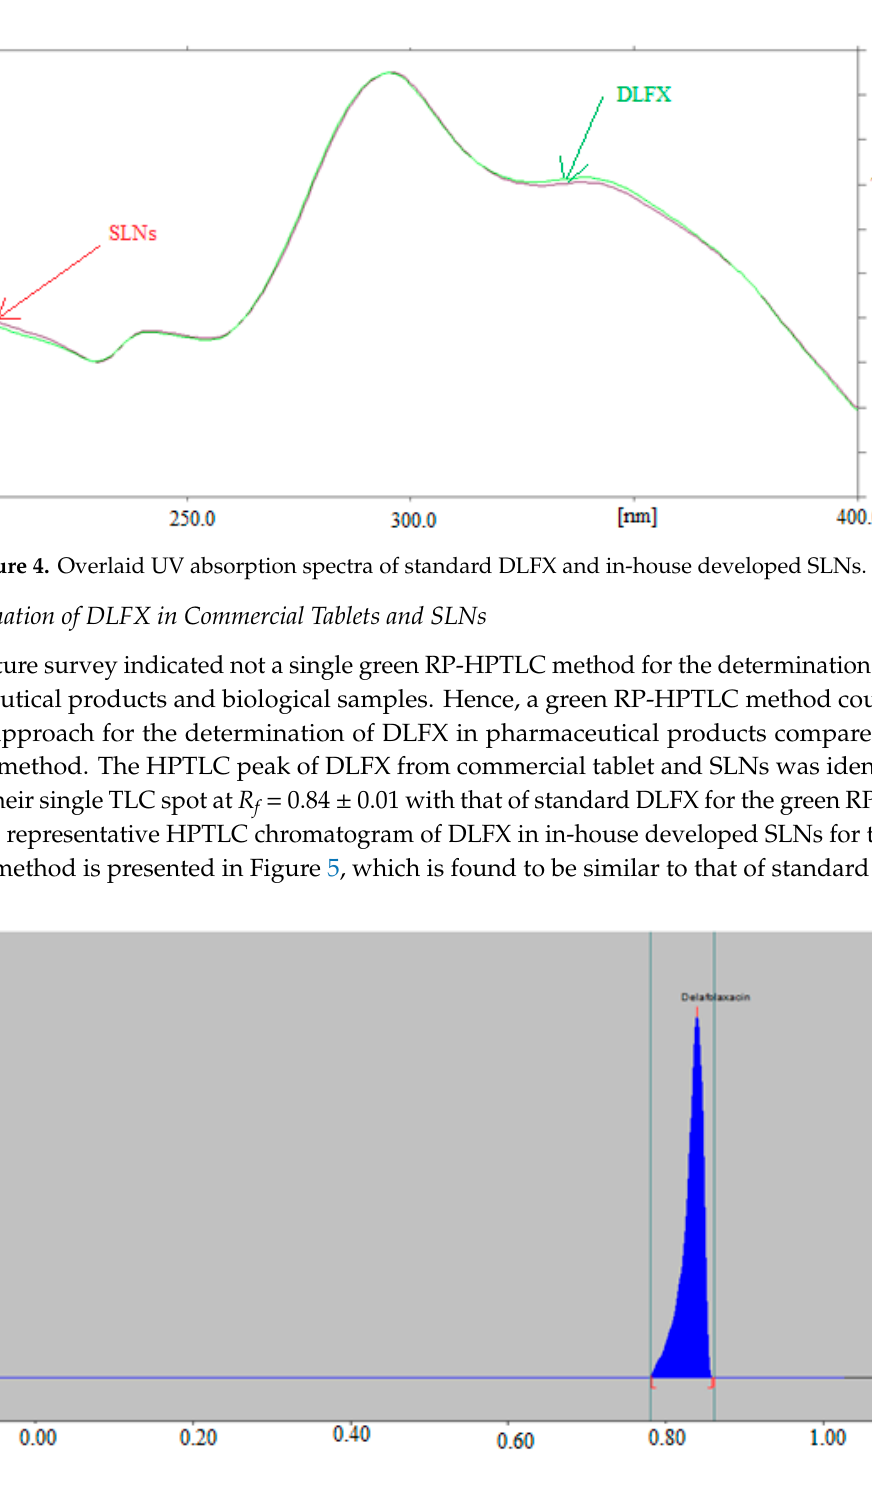
Figure 5. HPTLC chromatogram of DLFX in in-house developed SLNs by the green RP-HPTLC